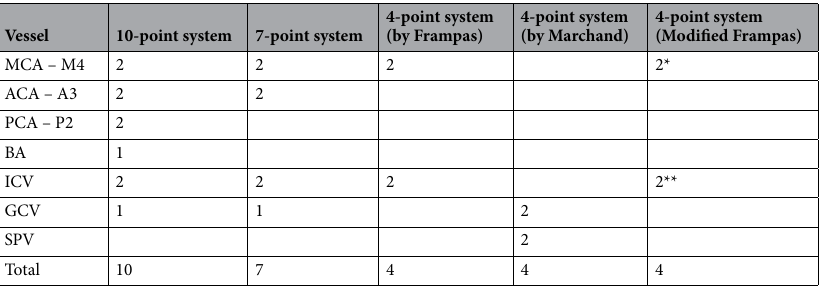
Table 1. Different CTA scoring systems for determination of brain death. MCA middle cerebral artery, ACA anterior cerebral artery, PCA posterior cerebral artery, BA basilar artery, ICV internal cerebral vein, GCV great cerebral vein, SPV superior petrosal vein. *Only in arterial phase. **Only in venous